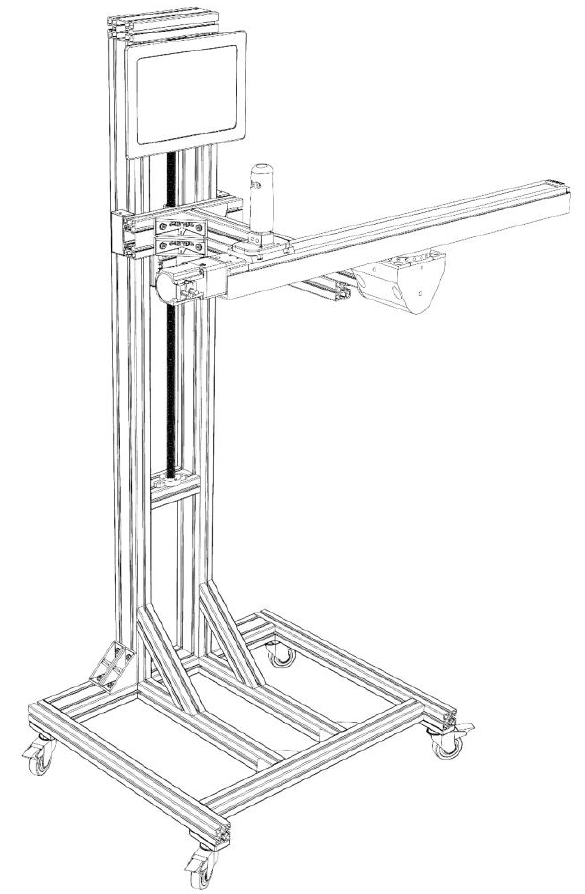
Figure 1. Schematic representation of Ablefit.